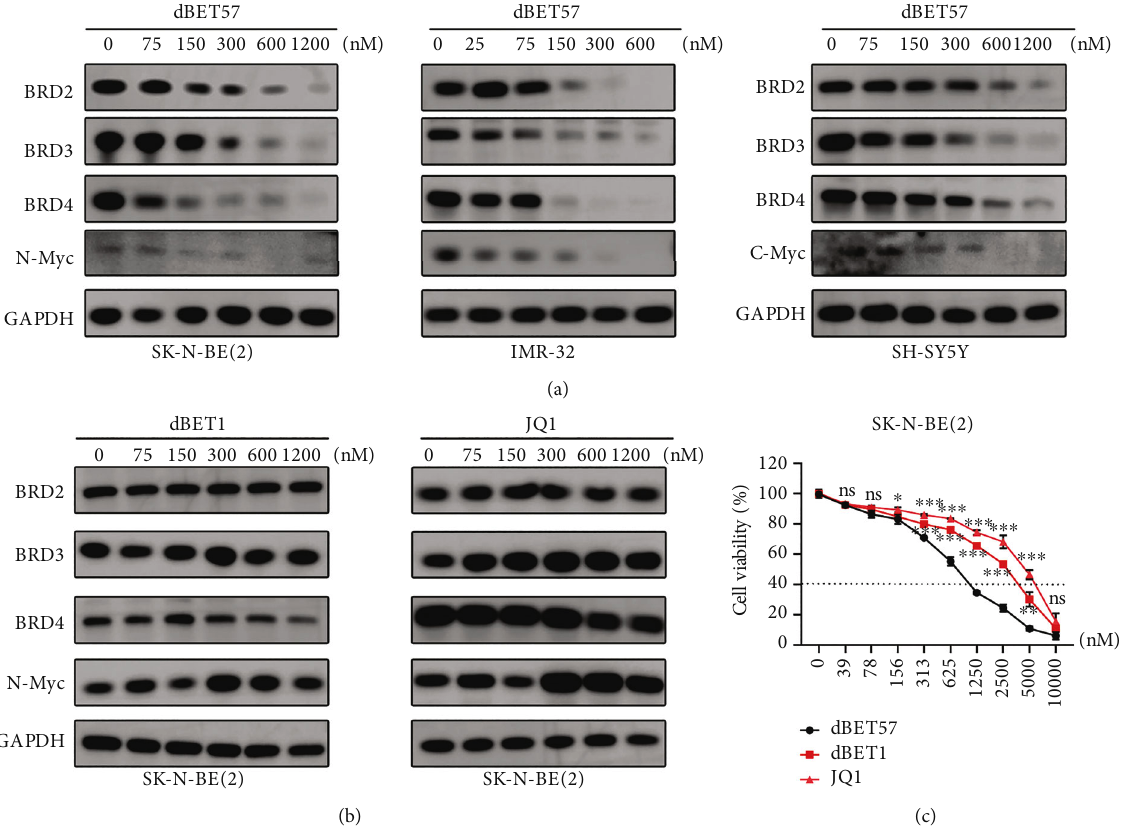
Figure 3: dBET57 reduces BET family proteins and MYC family proteins in NB cells. (a) Western blot quantitative analysis of the protein expression levels of BRD4, BRD3, BRD2, and n-Myc (or c-Myc). (b) Western blot analysis of the protein expression levels of BRD4, BRD3, BRD2, and n-Myc after SK-N-BE(2) cells were treated with di ff erent concentrations of dBET1 and JQ1 for 48 h. (c) The survival curve of SK- N-BE(2) cells treated with the same concentration of dBET1, dBET57, and JQ1 for 72 hours. The experimental groups (dBET1 and JQ1) were compared with the control group (dBET57). ∗ p < 0 : 05 , ∗∗ p < 0 : 01 , and ∗∗∗ p < 0 : 001 ; ns: not signi fi